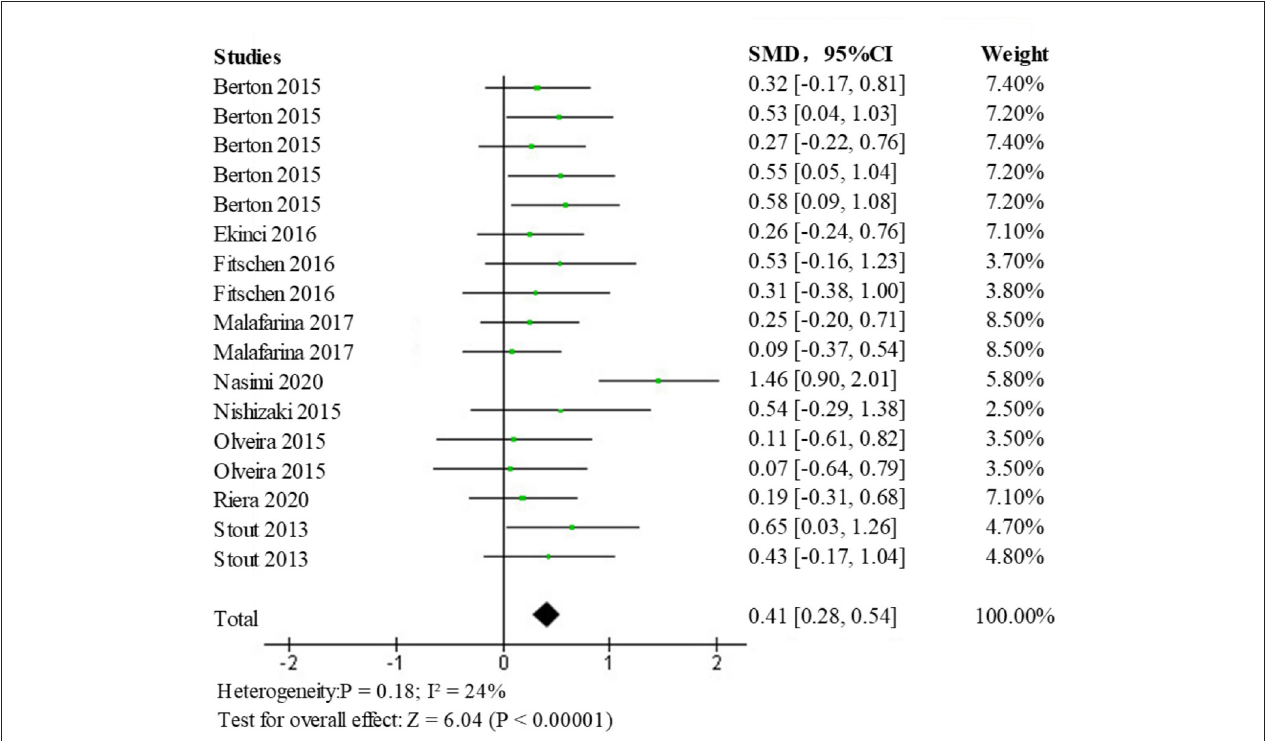
FIGURE 8 | Forest diagram of the effect of HMB on muscle